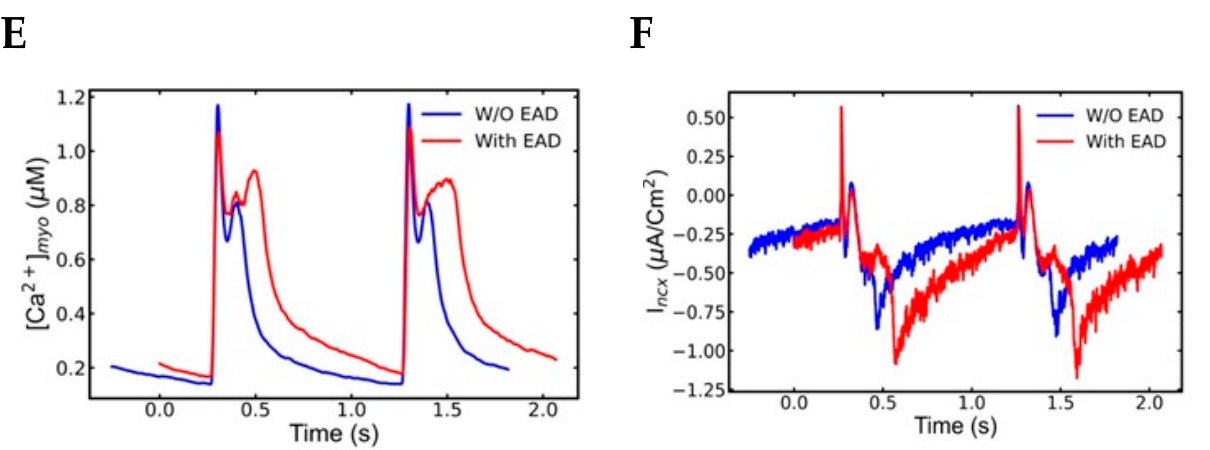
Figure 6. A comparison of AP, channel gating, Ca 2+ transients, and ionic currents during β -adrenergic receptors activated myocytes show spontaneous Ca 2+ release develops EADs in the second slow pacing after myocyte went through rapid pacing. The plots represent the combined simulations of 7.5 s to 9.5 (blue) s and 21.5 s to 23.5 s (red). ( A ) A normal action potential in the slow pacing ahead of the rapid pacing (blue), but it changed in the subsequent slow phase right after the rapid pacing where action potential developed EADs. ( B ) L-type channel current. ( C ) The RyR2 channels spontaneously release Ca 2+ . ( D ) High [Ca 2+ ] SR is responsible for spontaneous Ca 2+ release. ( E ) Cytoplasmic Ca 2+ level ([Ca 2+ ] myo ) changes after spontaneous Ca 2+ release and late reactivation of L-type Ca 2+ channels. ( F ) An increased activity of Na + -Ca 2+ exchange current (I ncx ) is supportive of elongate APD. The simulation was repeated 10 times with different seeds for the pseudo random number generator and the patterns observed were repeated each time. Shown here is a representative simulation.